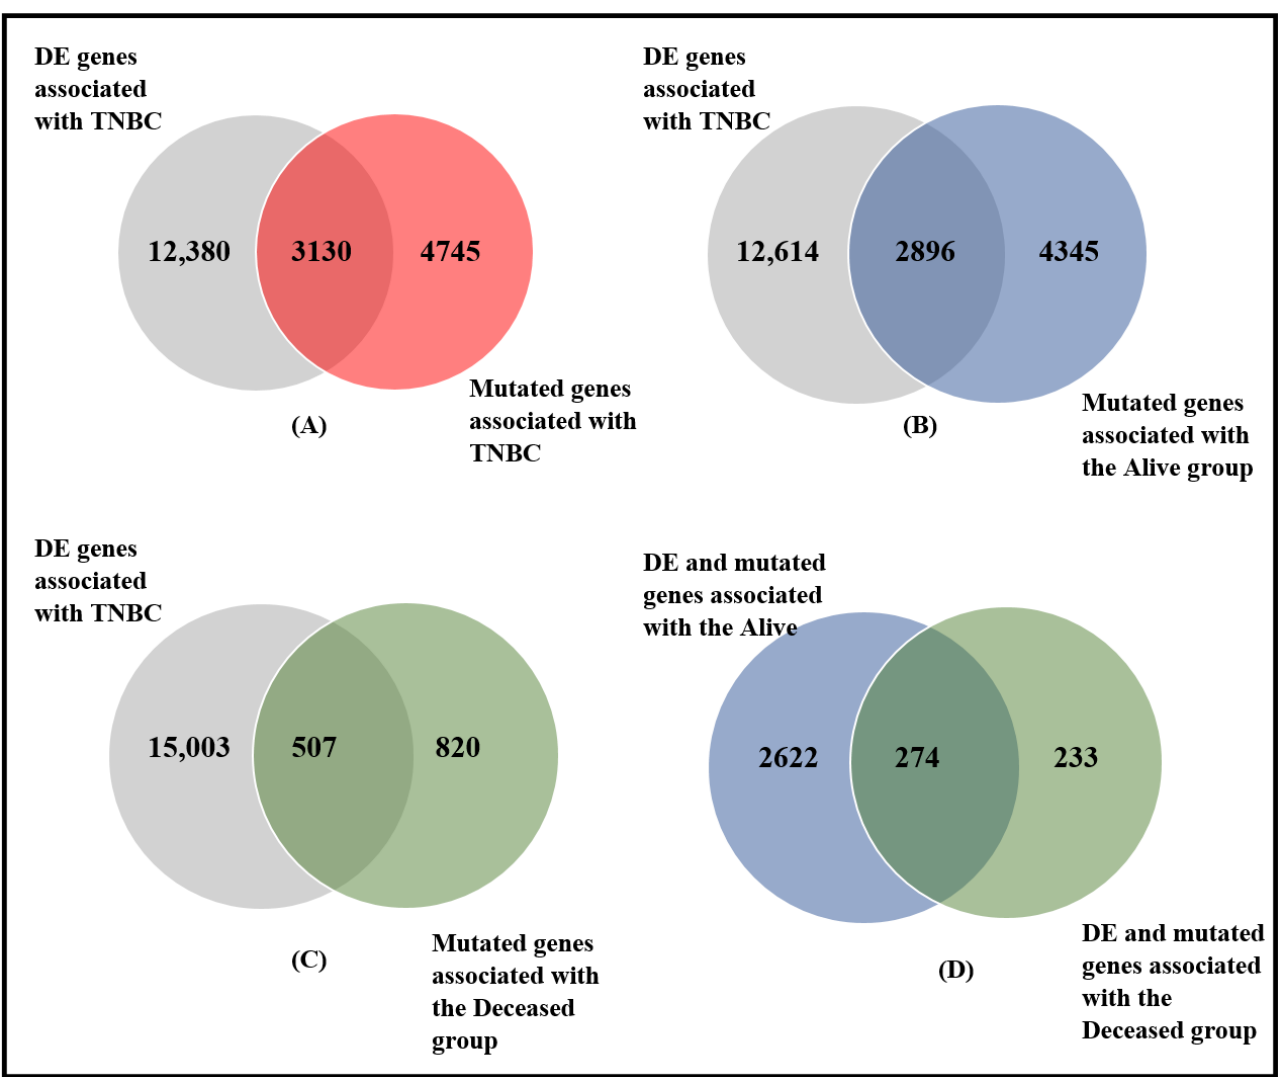
Figure 2. Distribution of somatic mutated and non-mutated genes significantly associated with TNBC: ( A ) genes altered in both the tumor genome and the transcriptome (see intersection), ( B ) genes with both somatic and expression alterations in the alive group (intersection), ( C ) genes with both somatic and expression in the deceased group (intersections), and ( D ) differentially mutated genes between alive and deceased patient groups transcriptionally associated with TNBC. In ( C ) genes in the intersections were associated with both groups. DE = differential expression.